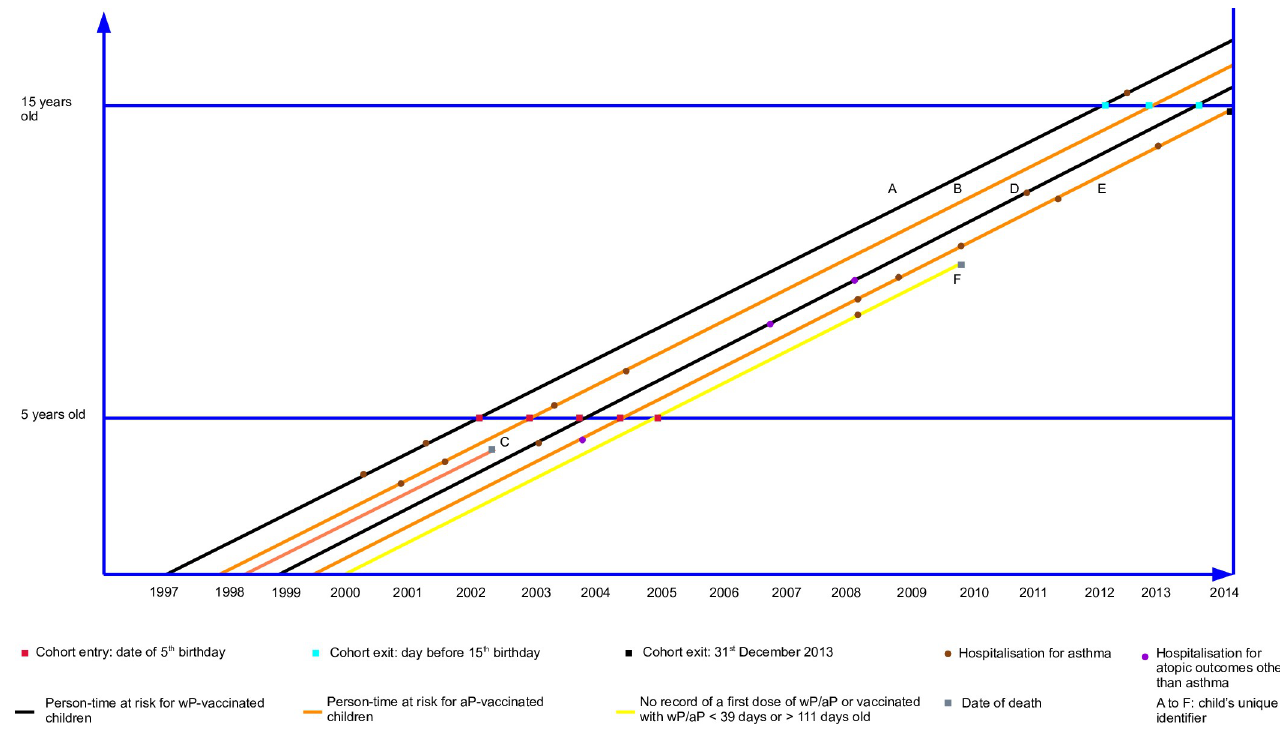
Fig 1. Lexis diagram (before data cleaning). Legend: Person-time-at-risk experience of children born in WA or NSW between 1 January 1997 and 31 December 1999 before data cleaning.